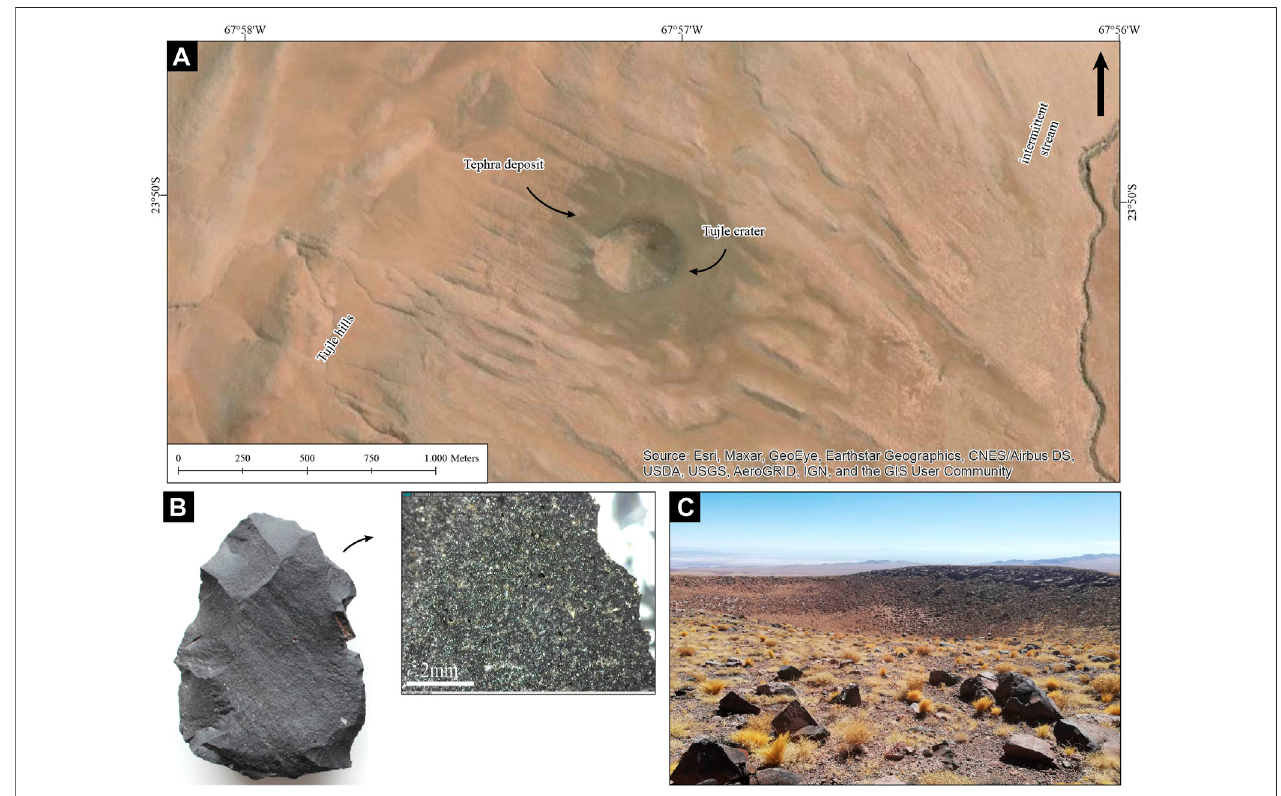
FIGURE 7 | Cerro Tujle source: (A) geological context; (B) raw material sample; (C) quarry-workshop site near to the crater